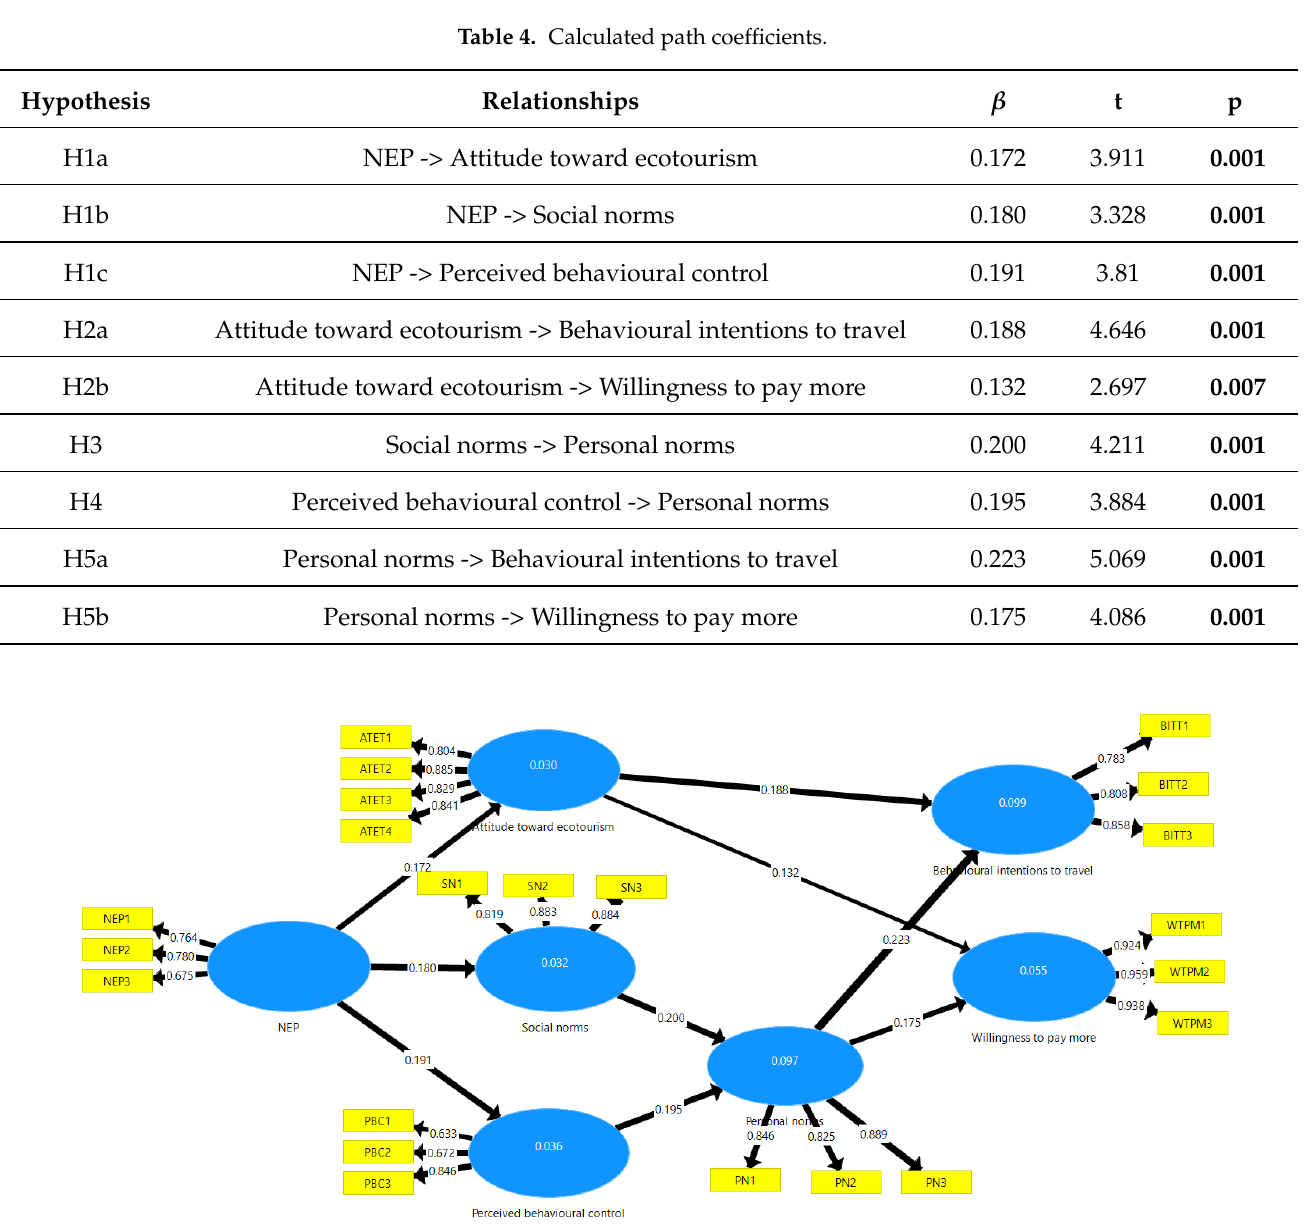
Figure 2. Verified behavioural model of the relationships between the